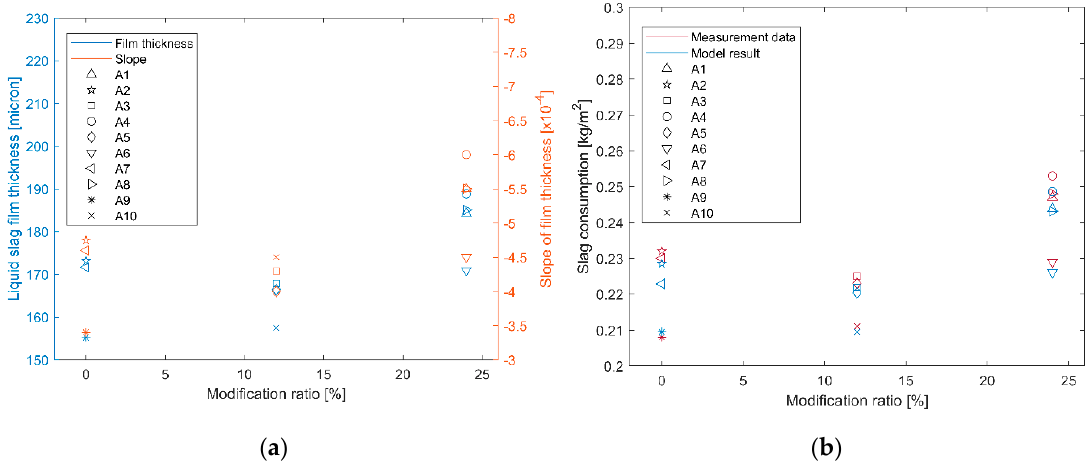
Figure 11. ( a ) Liquid film thickness, slope of the film, and ( b ) slag consumption with different modification ratio for non-sinusoidal mold oscillation (Case A1–A10).